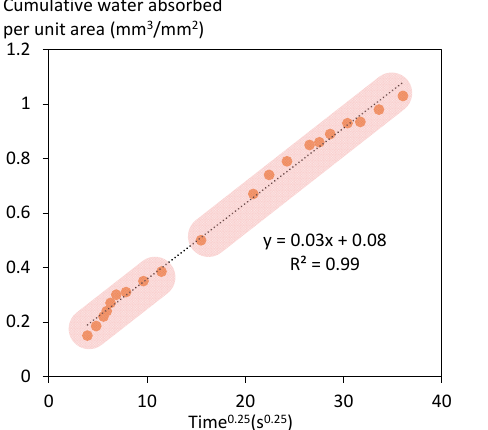
Figure 1. Capillary water uptake in concrete tested for 368 hours, data from